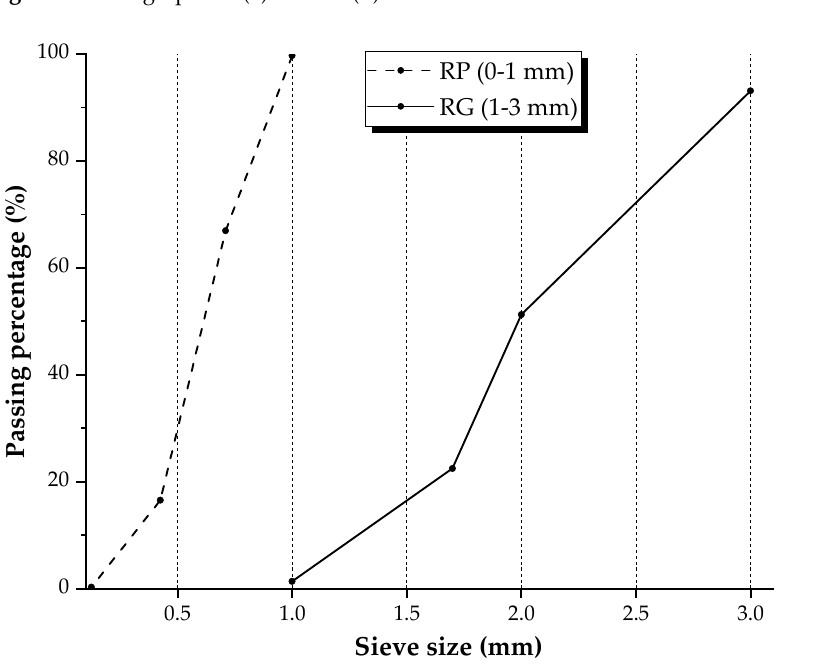
Figure 3. Particle size distribution of RP and RG.